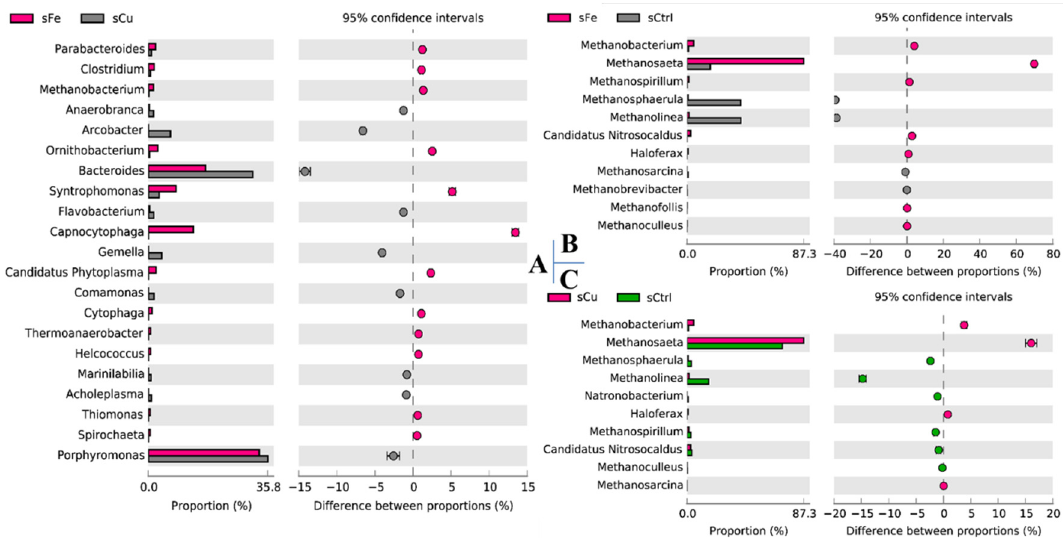
Figure 6. The STAMP plot comparing the microbial community of the AnMBR with long-term ferric and copper augmentation: ( A ) sFe and sCu, ( B ) sFe and sCtrl, and ( C ) sCu and sCtrl. The Methanosaeta is stimulated by both ferric and copper. The ferric dosage also stimulated Flavobacterium and Syntrophomonas as syntrophic methanogenic consortia, while copper inhibited them, e.g., Bacteroides